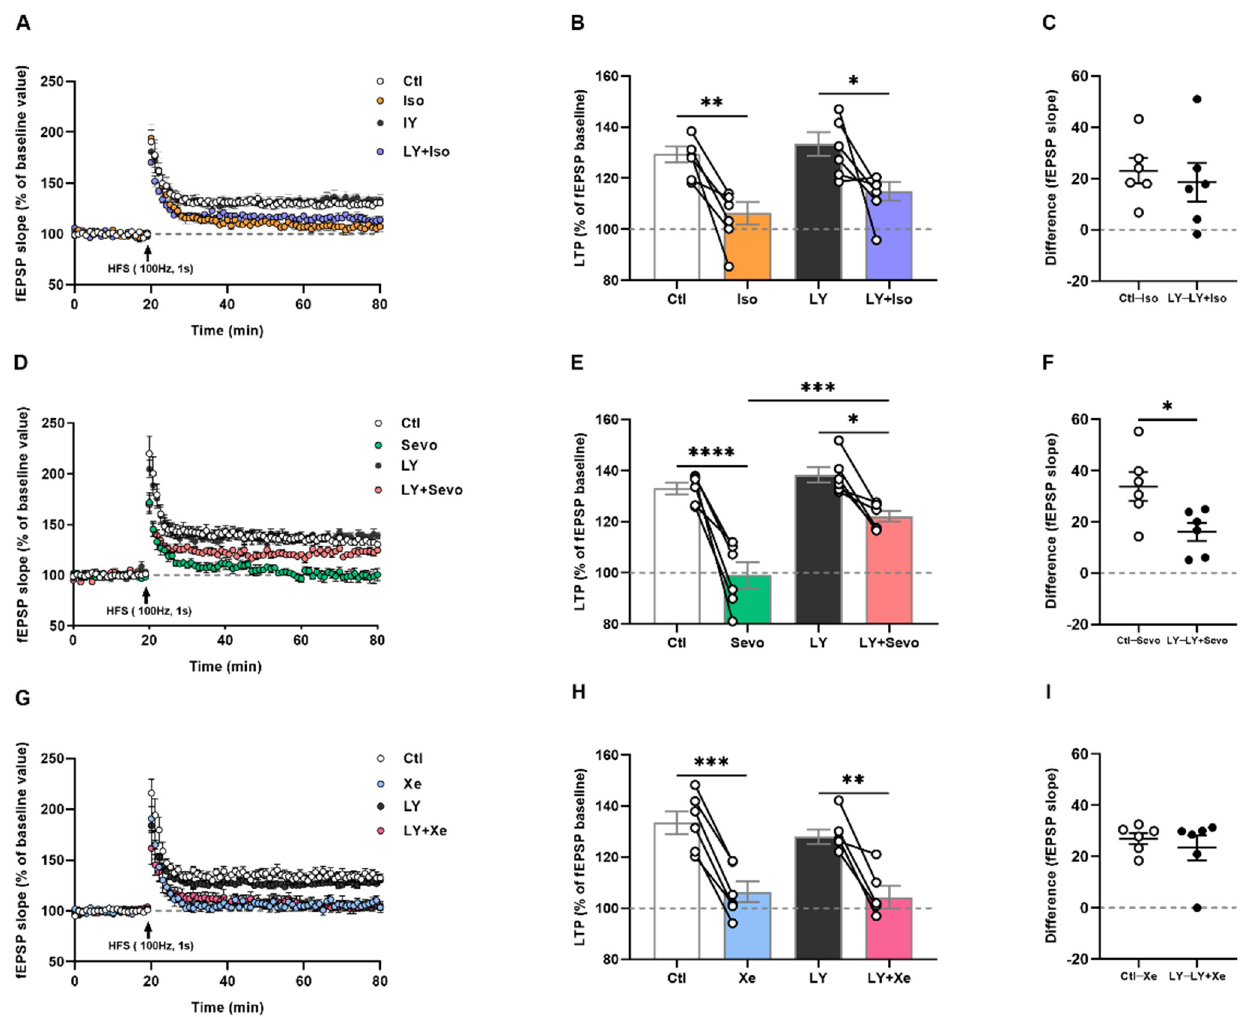
Figure 7. BACE inhibition partly restored sevo-, but not iso- or Xe-induced LTP deficits. Under control and LY application conditions, an HFS train produced stable potentiation but not in the presence of iso, sevo, and Xe. ( A , D , G ) Normalized fEPSP values under all conditions. Sevo abolished potentiation, which was remarkably reversed by LY exposure ( D , E ), ctl vs. sevo: p < 0.0001, LY vs. LY + sevo: p = 0.0132, sevo vs. LY + sevo: p = 0.0005; One-way ANOVA followed with Tukey’s test) by comparison of the difference between ctl—LY and LY—LY + sevo (( F ), p = 0.0229, two-tailed unpaired t -test). In addition, LY application for 2 h in advance was not able to restore the impaired LTP caused by iso or Xe ( A – C , G – I ). Data are presented as mean ± SEM. For box plots in ( B , E , H ), dots represent the number of animals. Detailed statistics are provided in the Table S1. * p < 0.05, ** p < 0.01, *** p < 0.001, **** p < 0.0001. Ctl: control, fEPSP: field excitatory postsynaptic potentials, HFS: high-frequency stimulation, iso: isoflurane, LTP: long-term potentiation, LY: LY2886721, sevo: sevoflurane, Xe: xenon.